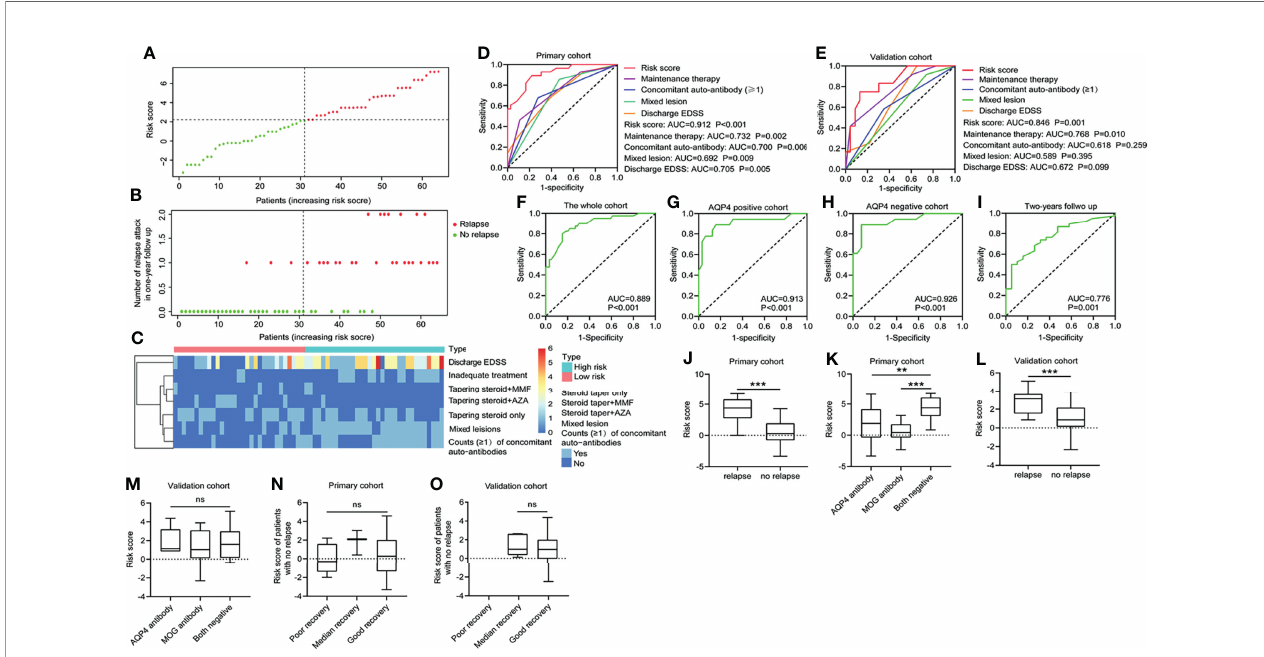
FIGURE 1 | Predictive value of the risk score model. (A, B) The 4-independent-factors signature risk score distribution with the relapse status of pediatric patients. The colorgram of 4-independent-factor expression pro fi les of high- and low-risk groups. The vertical line represents the median cutoff dividing patients into low- and high-risk groups. (C) The expression of cluster heatmap for the four risk factors in the primary cohort. ROC for recurrence in 1-year follow-up in the primary cohort (D) and validation cohort (E) using risk score compared with other indicators. ROC for recurrence in 1-year follow-up in the whole cohort (F) , AQP4 antibody-positive cohort (G) , AQP4 antibody-negative cohort (H) , and the cohort with 2-year follow-up (I) . (J) Risk score distribution in the primary cohort with or without relapse in 1-year follow-up. (K) Risk score distribution of different antibody types in the primary cohort. (L) Risk score distribution in the validation cohort with/without relapse in 1-year follow-up. (M) Risk score distribution of different antibody subsets in the validation cohort. For patients without relapse in 1-year follow-up, risk score distribution was detected in the primary cohort (N) and the validation cohort (O) according to different clinical outcomes at 1 year. EDSS, Expanded Disability Status Scale; AQP4, aquaporin-4; MOG, myelin oligodendrocyte glycoprotein; AZA, acetazolamide; MMF, mycophenolate mofetil; ns, not statistically signi fi cant; ROC, receiver operating characteristic. **p < 0.01 and ***p <